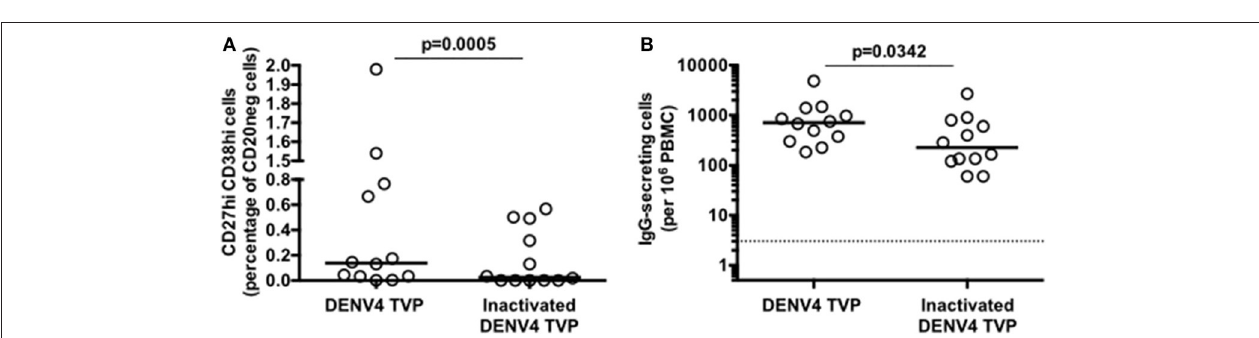
FIGURE 2 | Inactivated Dengue virus particles do not have the same ability to trigger the B cell differentiation into antibody-secreting cells (ASCs) as whole particles do. (A) Percentage of ASCs quantified through FACS and (B) magnitude of IgG-secreting cells detected through ELISPOT at day 7 of PBMC cultures derived from 12 healthy